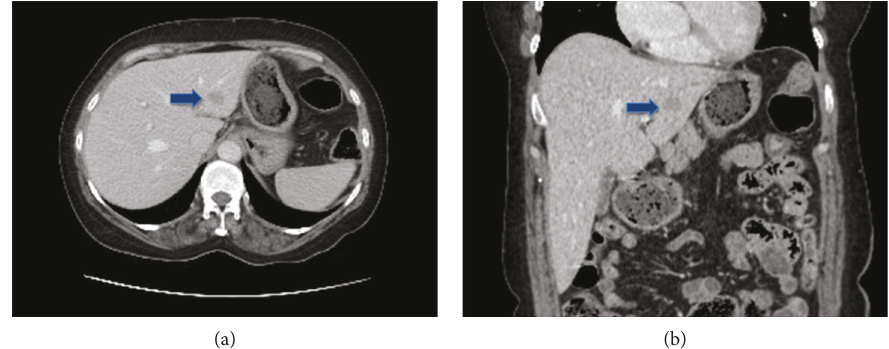
Figure 1: Computed tomography (CT) axial image showing an irregular hypodense lesion in the left lateral section of the liver in (a, blue arrow). The same lesion is shown in the coronal plane in (b, blue arrow).